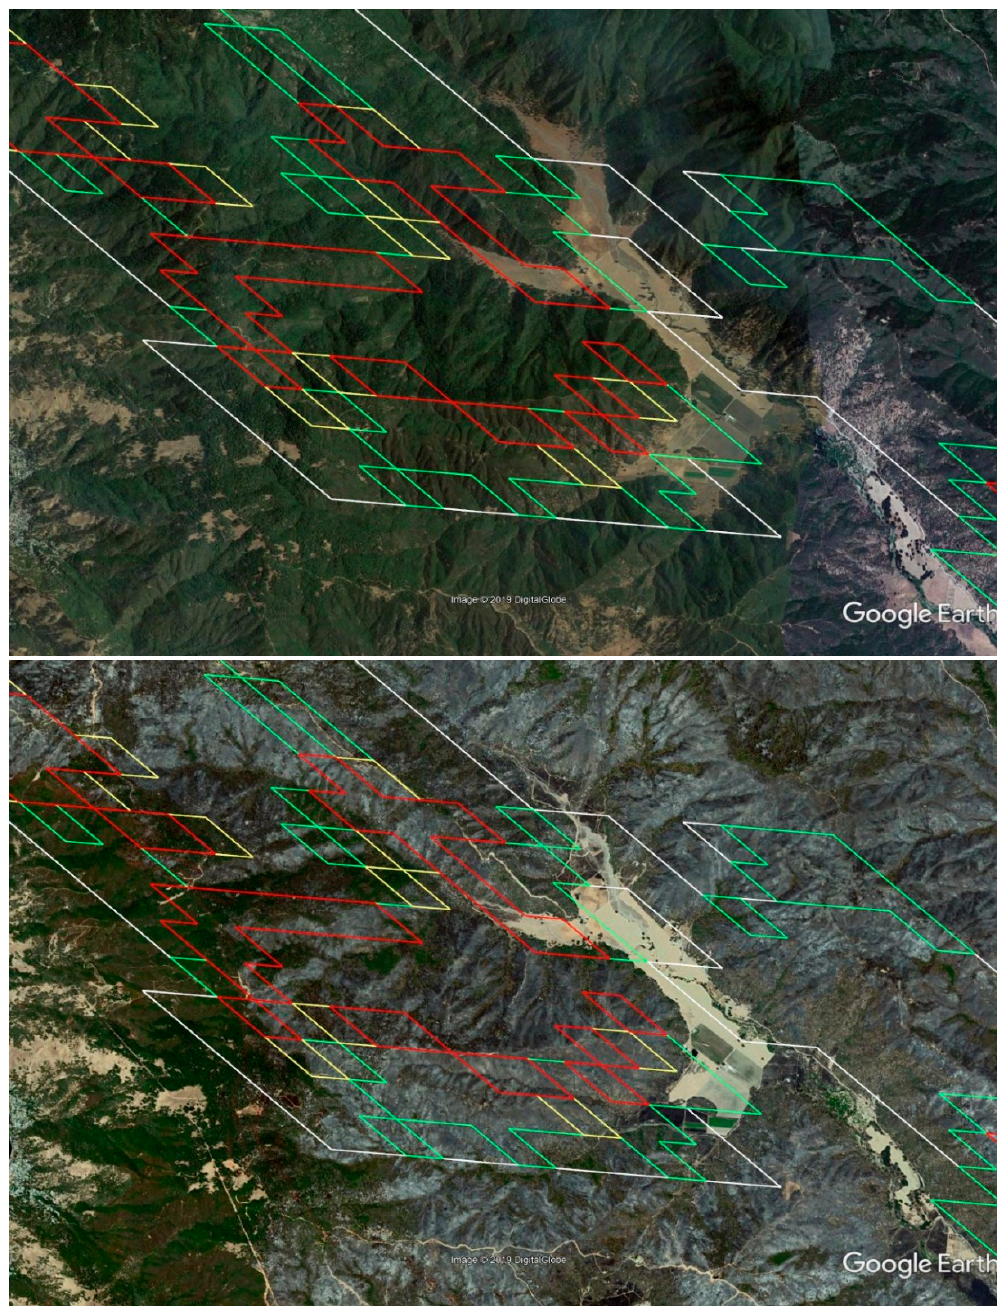
Figure 4. Proof of concept results over the Ranch fire centered on 39.100141°, W-122.717262° on 2 July 2018 before ( top ) the fire and 8 August 2018 after ( bottom ) the fire. Overlaid are the active fire detections on 4 August 2018, DOY 216. Colored outlines mark the 500 m high (red), moderate (yellow), low (green) and poor (white) probabilities of containing active fires. It is evident that the high probability 500 m pixels show extensive fire damage while the low to poor probability pixels are less a ff ected. Low and poor probability pixels are distinctly visible over the dry riverbed. Base imagery from Google Earth ™